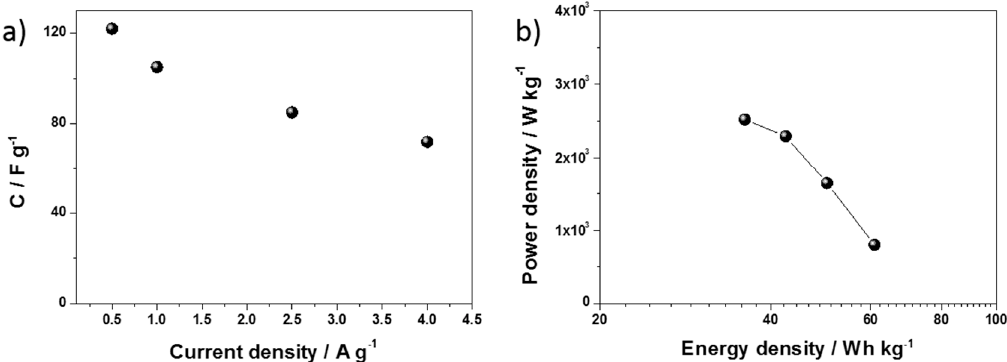
Figure 9. ( a ) Dependence of the specific capacitance of the hydrated WO 3 − x electrode on the current density. ( b ) Ragone plot relating the energy and power densities of hydrated WO 3 − x (in a two-electrode configuration).